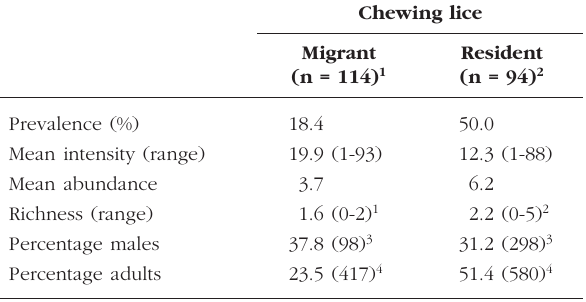
Table IV. – Parasitological parameters of chewing lice collected from resident and migrating birds during pre-breeding period in 2007. Birds with extreme high number of chewing lice (one Turdus merula parasitized with 444 specimens of Brueelia merulensis ) or with extreme high number of examined birds ( Erithacus rubecula , n = 281 and Sylvia atricapilla , n = 114) are not